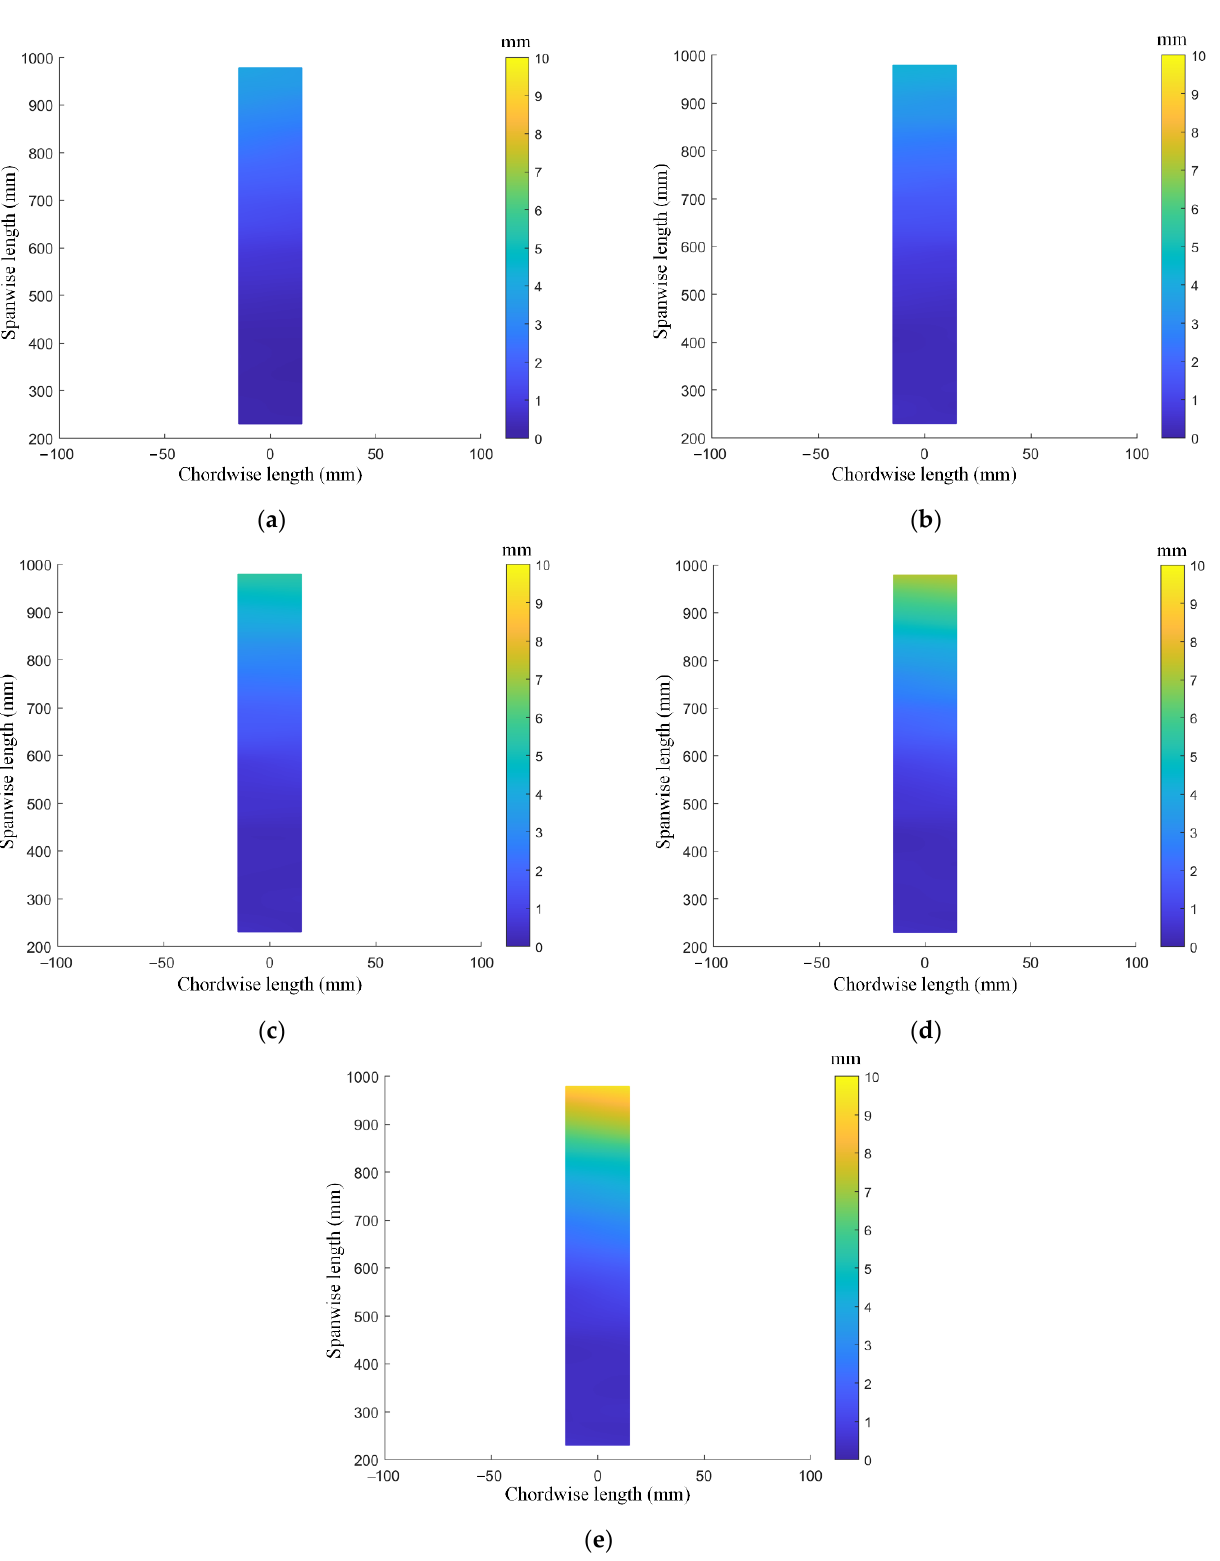
Figure 14. Average deformations of the rotor blade over its full rotating range at the collective pitch angles of ( a ) θ = 0°, ( b ) θ = 2°, ( c ) θ = 4°, ( d ) θ = 6° and ( e ) θ = 8°.